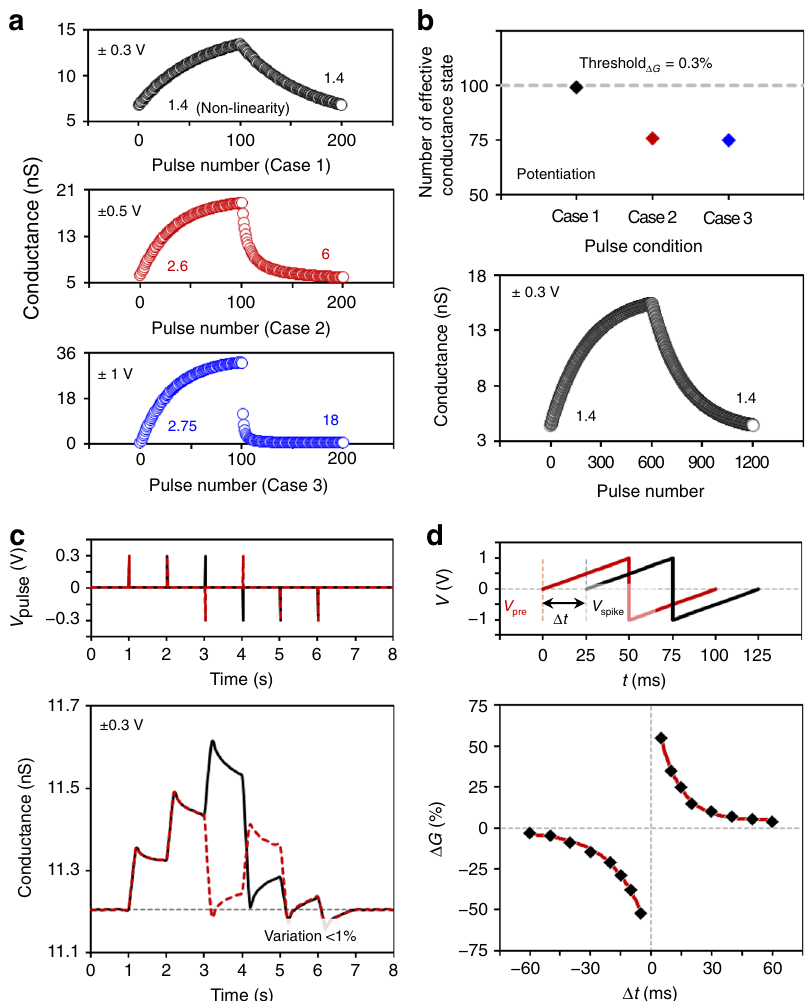
Fig. 3 Synaptic plasticity characterization of h -BN/WSe 2 synaptic device. a Long-term potentiation and depression characteristics by different input pulses with an amplitude of 0.3 V, 0.5 V, or 1 V. b Number of effective conductance states for the three cases with a threshold Δ G = 0.3%, and LTP/LTD curves when 600 pulses are applied in each potentiation and depression. c Stability of conductance states with below 1% variation. d Spike-timing-dependent plasticity behavior obtained in the h -BN/WSe 2 synaptic device. The pre-spike and post-spike voltages are applied to the presynaptic and SCT, respectively